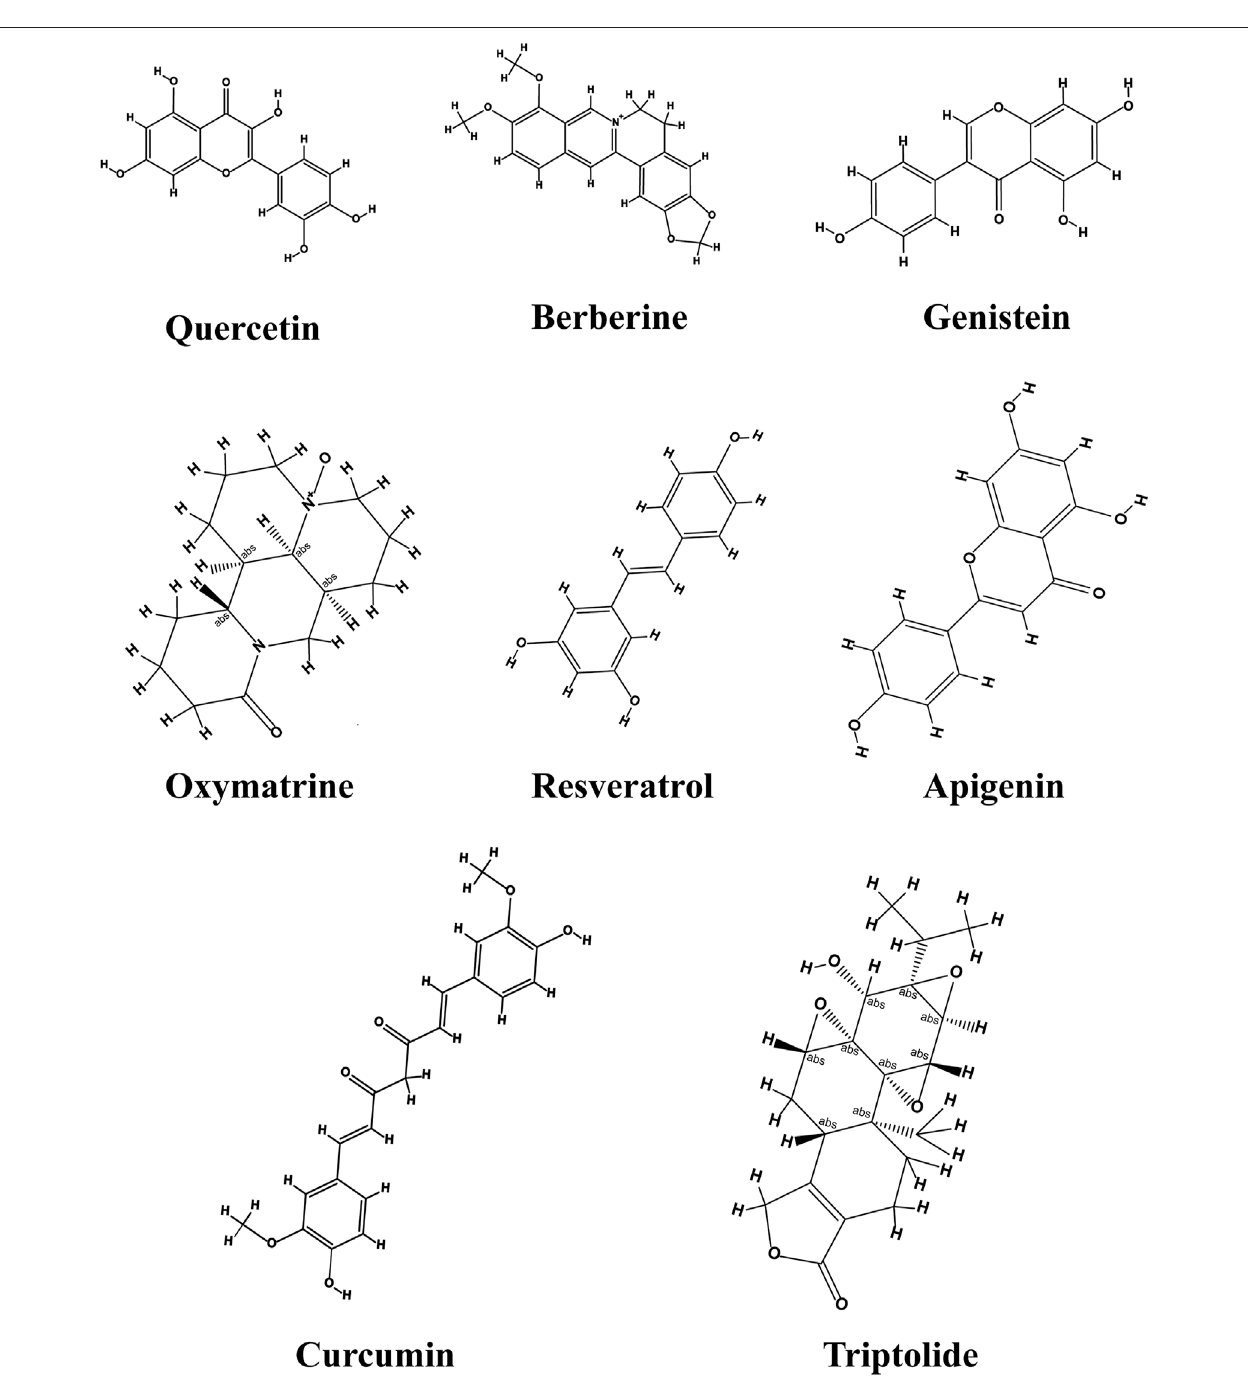
FIGURE 2 | Chemical structure of the main TCMs active constituents with anti-metastatic CRC ef fi cacy.